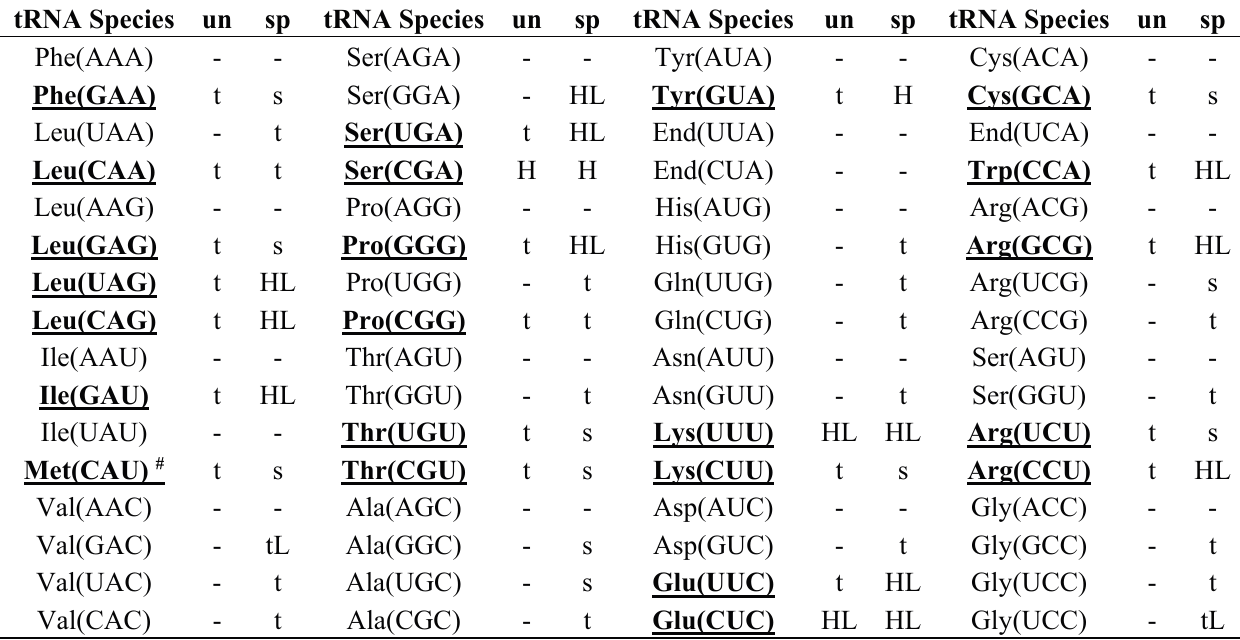
Table 2. Summary of actual S. tokodaii strain7 tRNAs confirmed by experimental identification of representative cDNAs